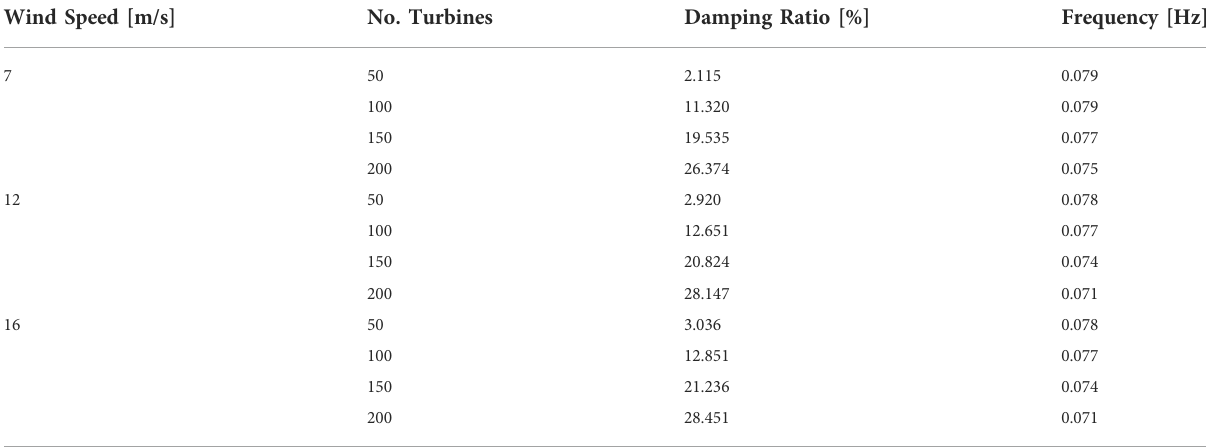
TABLE 4 Variation in number of turbines, delay time of 100 m s, gain of 25. Wind Speed